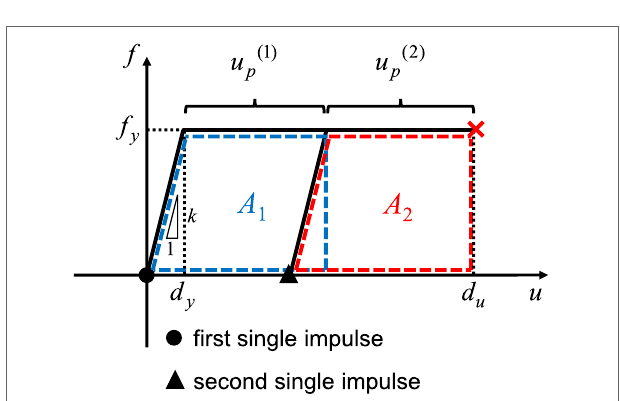
FIGURE 12 | Scenario to building collapse just after two impulses (collapse limit is given by maximum deformation) .